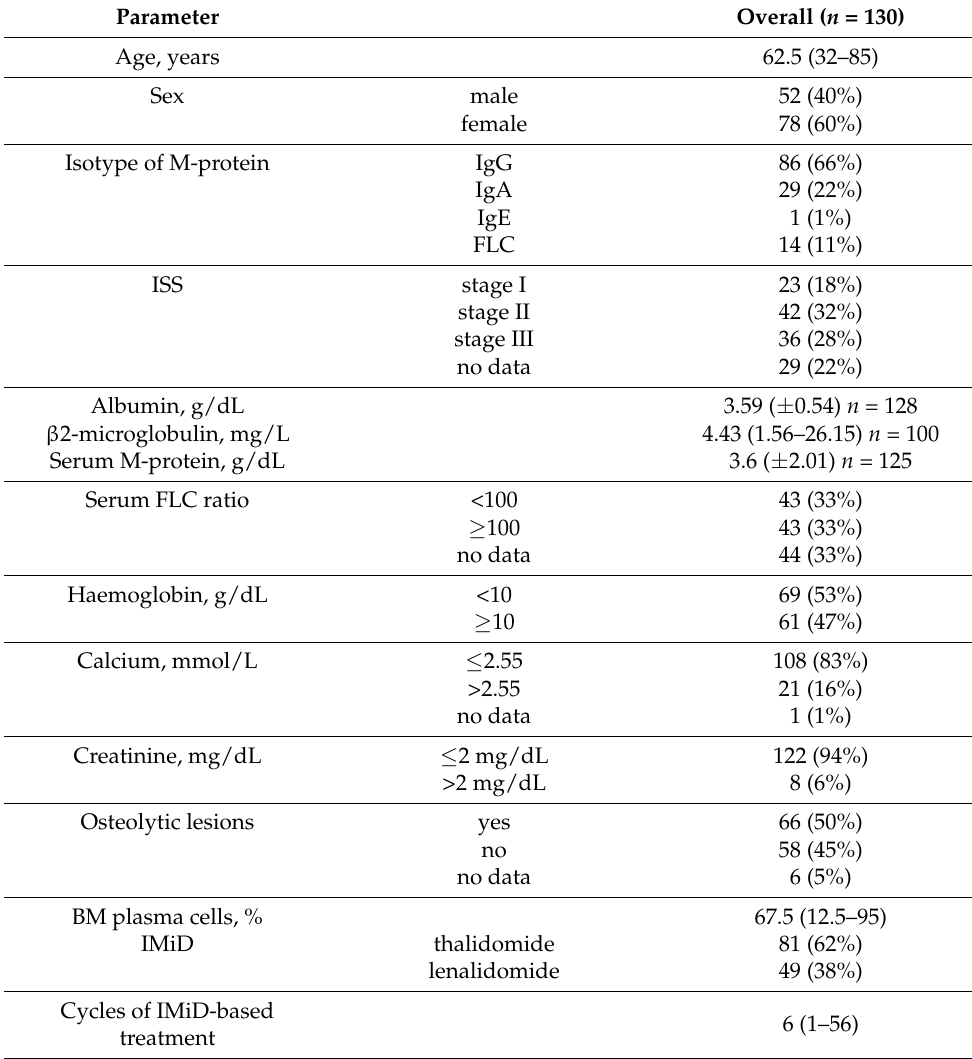
Table S1. The final analyses were performed with data from all of the patients treated with IMiD-based regimens. Table 1. Overall clinical patients’ characteristics. Data are shown as a number (percentage) or median (interquartile range). Abbreviations: ISS—International Staging System; FLC—free light chain; BM—bone marrow; IMiD—immunomodulatory